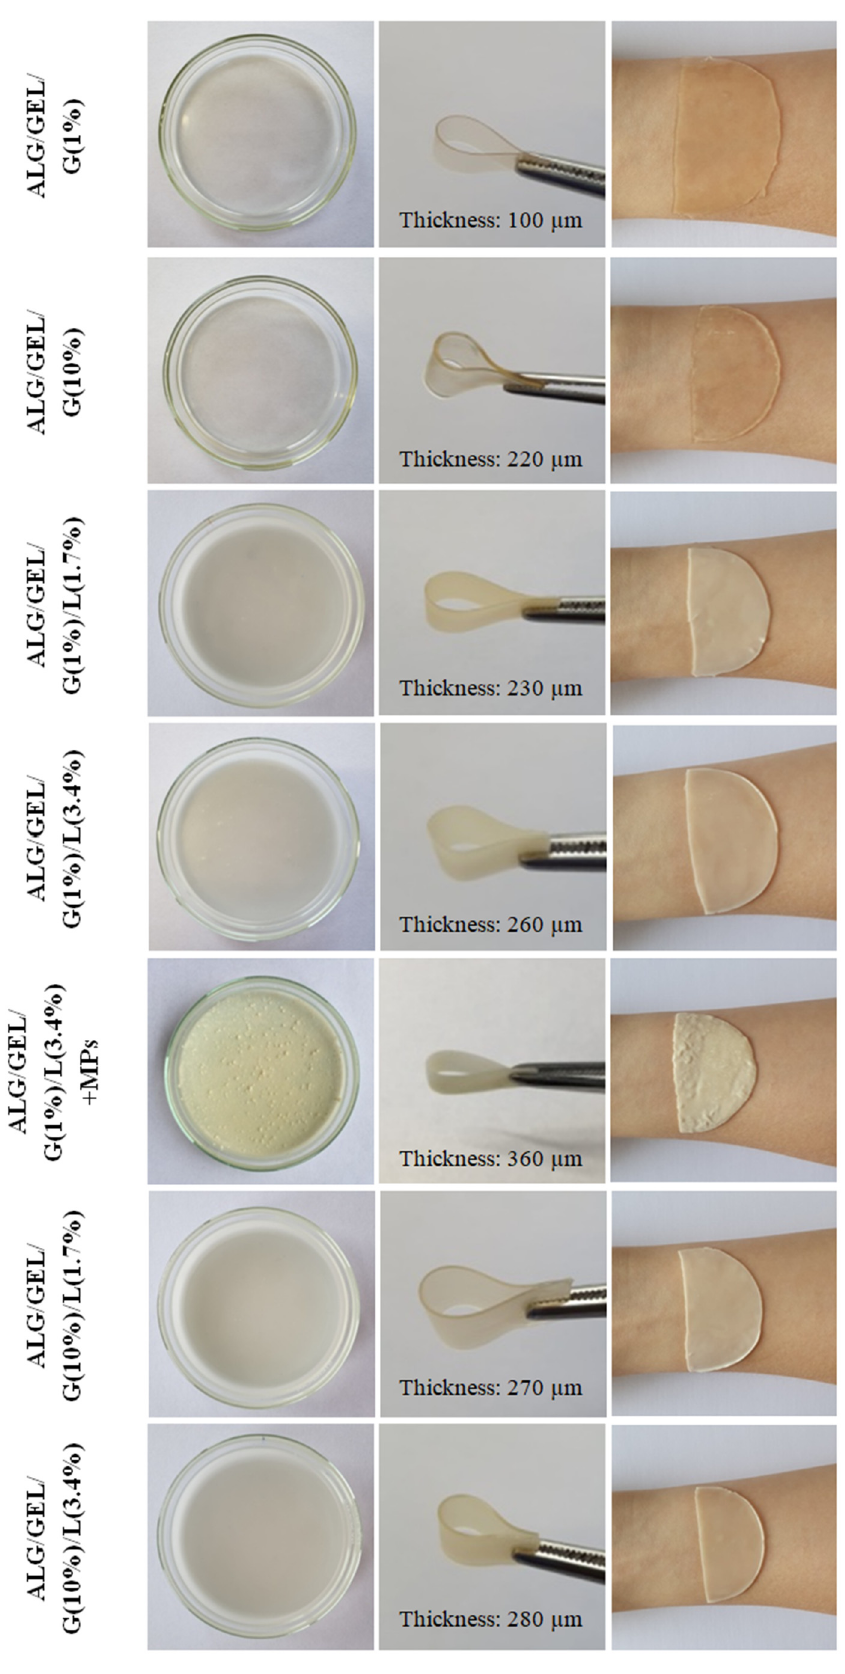
Figure 3. Photographs of prepared polymeric films and swollen polymeric films applied on the volar forearm skin.